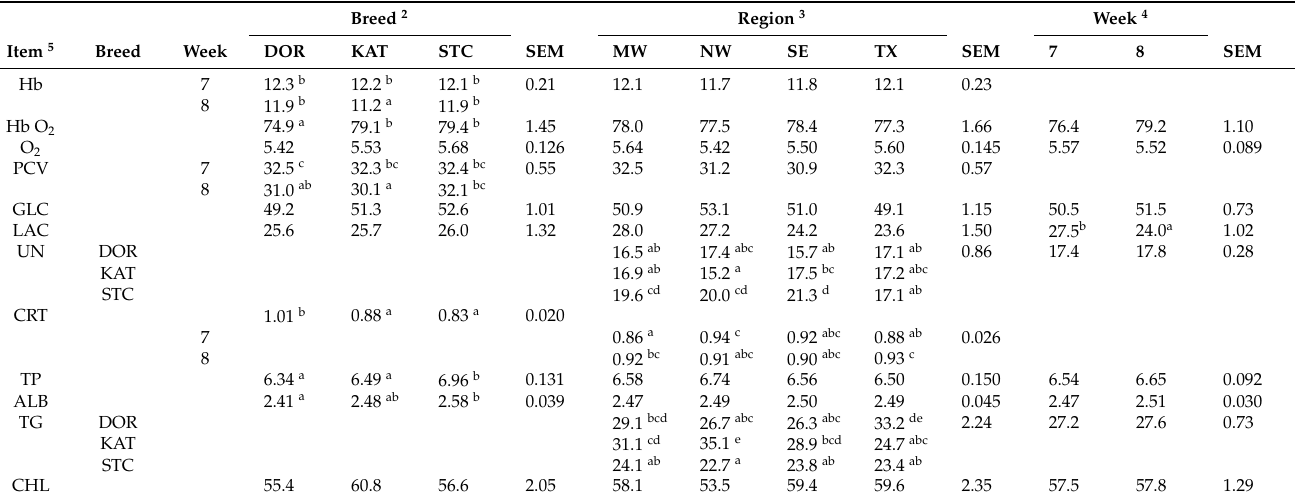
Table 7. Effects of breed, region, and week within period 4 on hemoglobin concentration and oxygen saturation, blood O 2 concentration, packed cell volume, and serum concentrations of glucose, lactate, urea nitrogen, creatinine, total protein, albumin, triglycerides, and cholesterol in hair sheep 1 . Breed 2 Region 3 Week